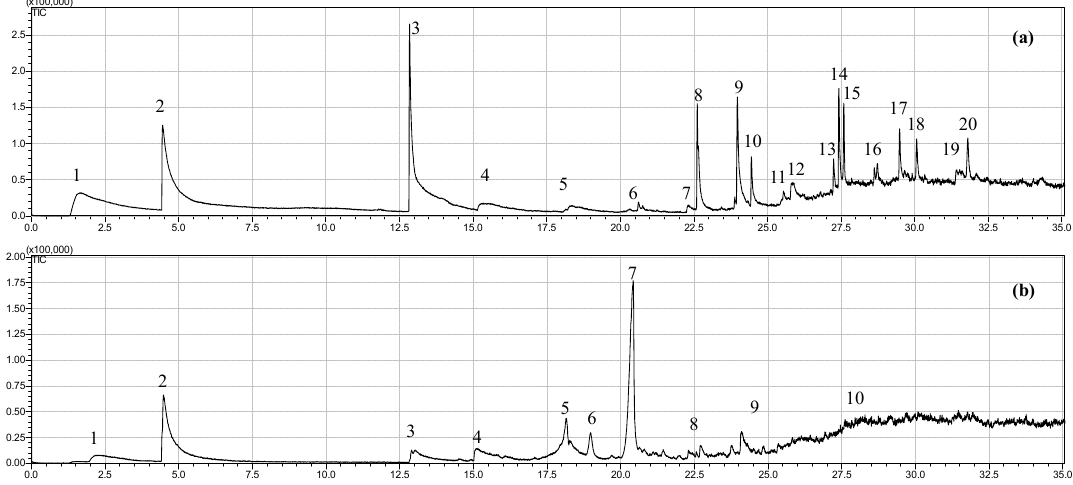
/ MS pyrograms P(ESES) detected at ( a ) 500 and ( b ) 600 ◦ C. Figure 10. Py-GC/MS pyrograms P(ESES) detected at ( a ) 500 and ( b ) 600 °C. Figure 10. Py-GC The Py-GC / MS pyrograms from P(ESDPA) homopolymer obtained at 400, 500 and 600